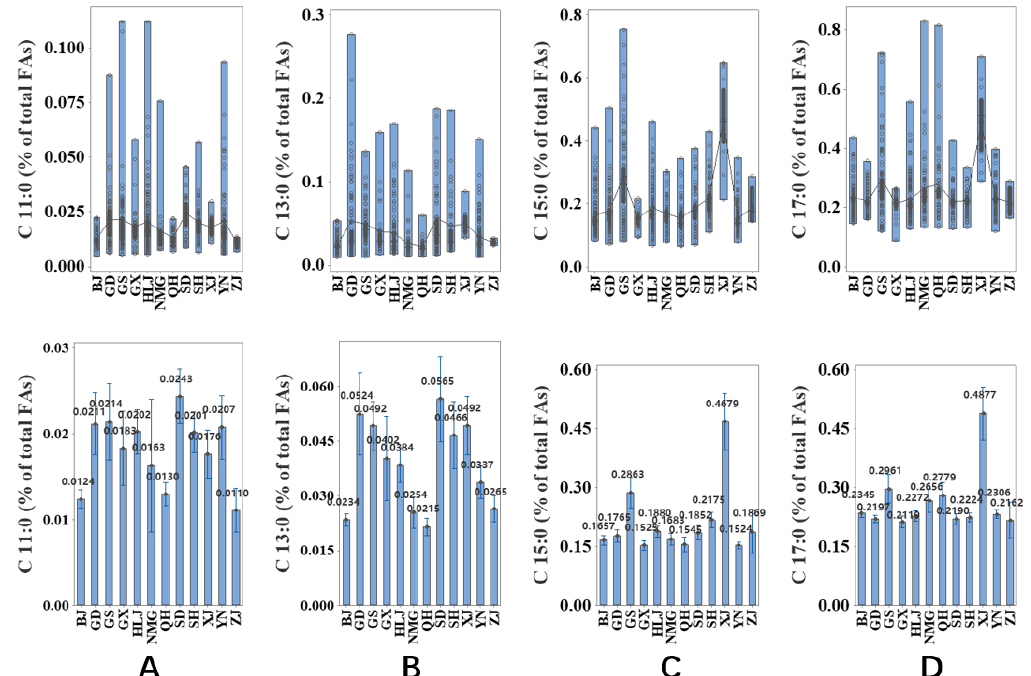
Figure 3. Association between location and the odd-chain fatty acids ( A :C11:0, B : C13:0, C : C15:0, D : C17:0) in human milk. Undecylic acid = C11:0; Tridecylic acid = C13:0; Pentadecylic acid = C15:0; Margaric acid = C17:0; BJ = Beijing; GS = Gansu; GD = Guangdong; GX = Guangxi; HLG = Heilongjiang; NMG = Neimenggu; QH = Qinghai; SD = Shangdong; SH = Shanghai; XJ = Xinjiang; YN = Yunnan; ZJ = Zhejiang.